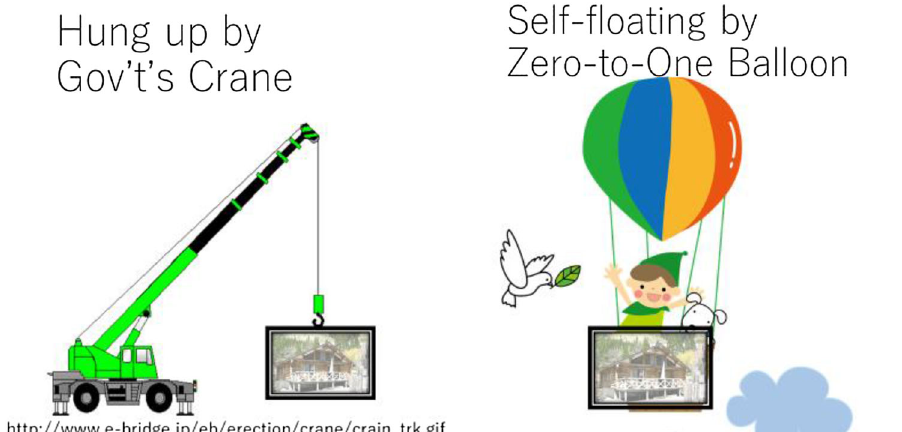
Fig. 5 Conventional top-down rescuing approach by the government like a lifting crane (left) versus the bottom-up approach by the Zero-to-One scheme like a rising balloon